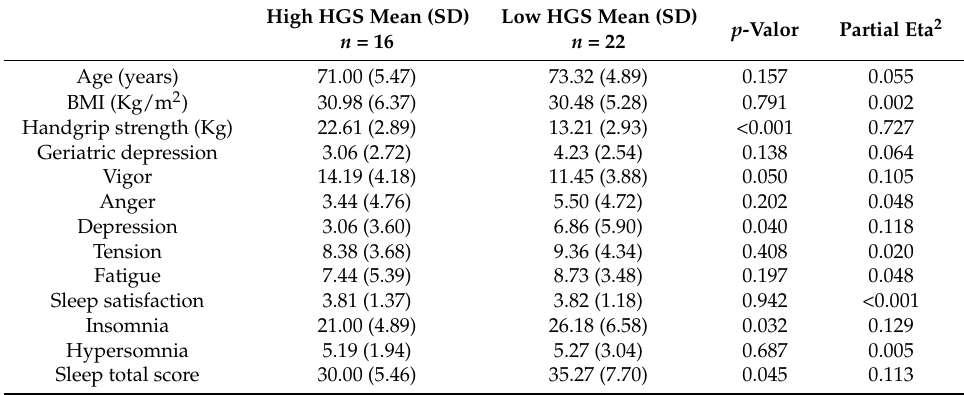
Table 1. Results of age, BMI, HGS, geriatric depression, mood and sleep taking into account the groups of high HGS and low